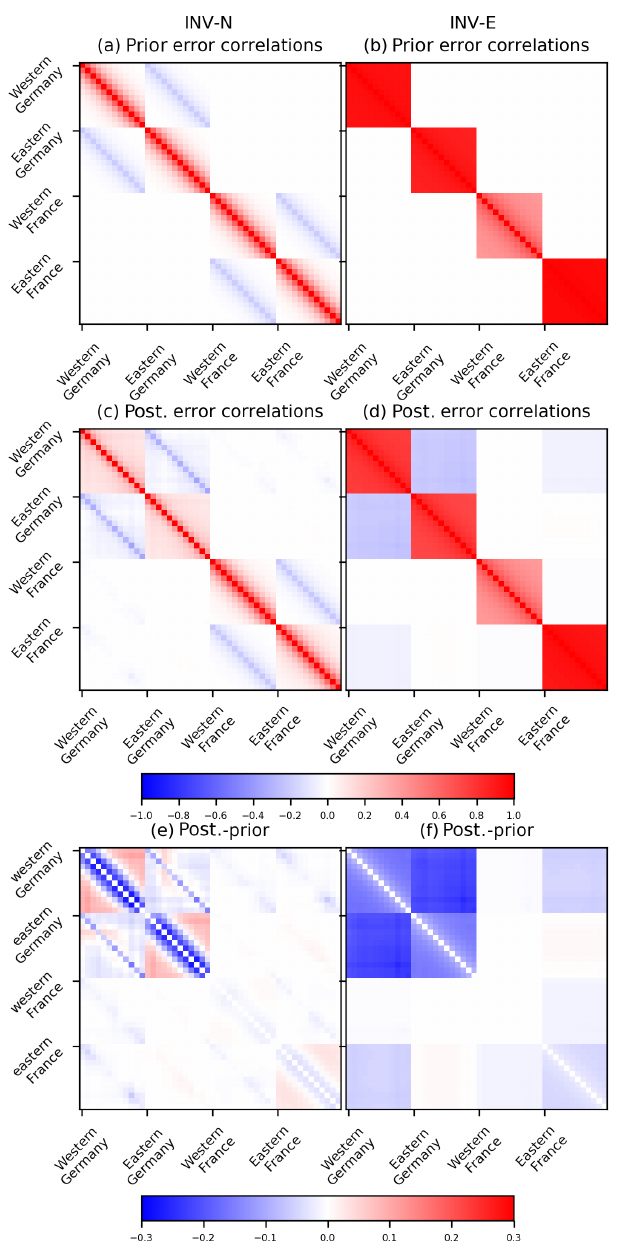
Figure 6. The correlation structure in the prior (first row) and pos- terior (second row) uncertainties in monthly regional FFCO 2 emis- sions for the four Germany and France regions using the NET43 network and 2-week sampling for INV-N (first column) and INV- E (second column) inversions, as well as their differences (third row). The x and y axes cover all the control region–months iter- ating through region first and months second (the blocks of pixels in each matrix). For clarity, we group these correlations into four regions and organize them for each region according to month in-